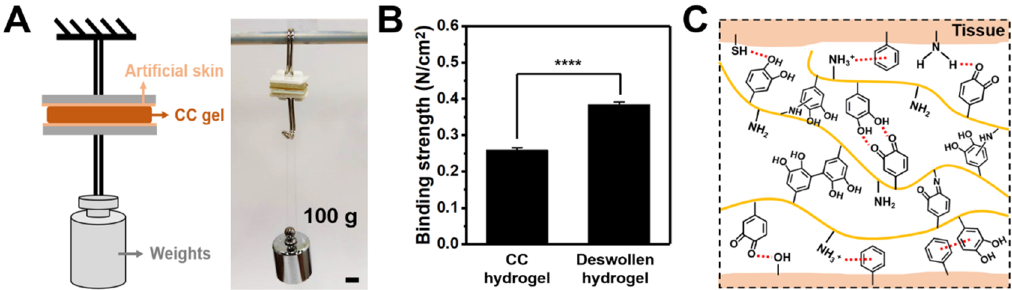
Figure 8. Adhesive properties of the CC hydrogel. ( A ) A weight-bearing equipment showing the binding between two pieces of artificial skins by the CC hydrogel. ( B ) The binding strength of the hydrogel and the deswollen one in saline for 12 h. **** represents p < 0.0001. ( C ) Illustration of the possible adhesive mechanism of the CC hydrogel with tissue.